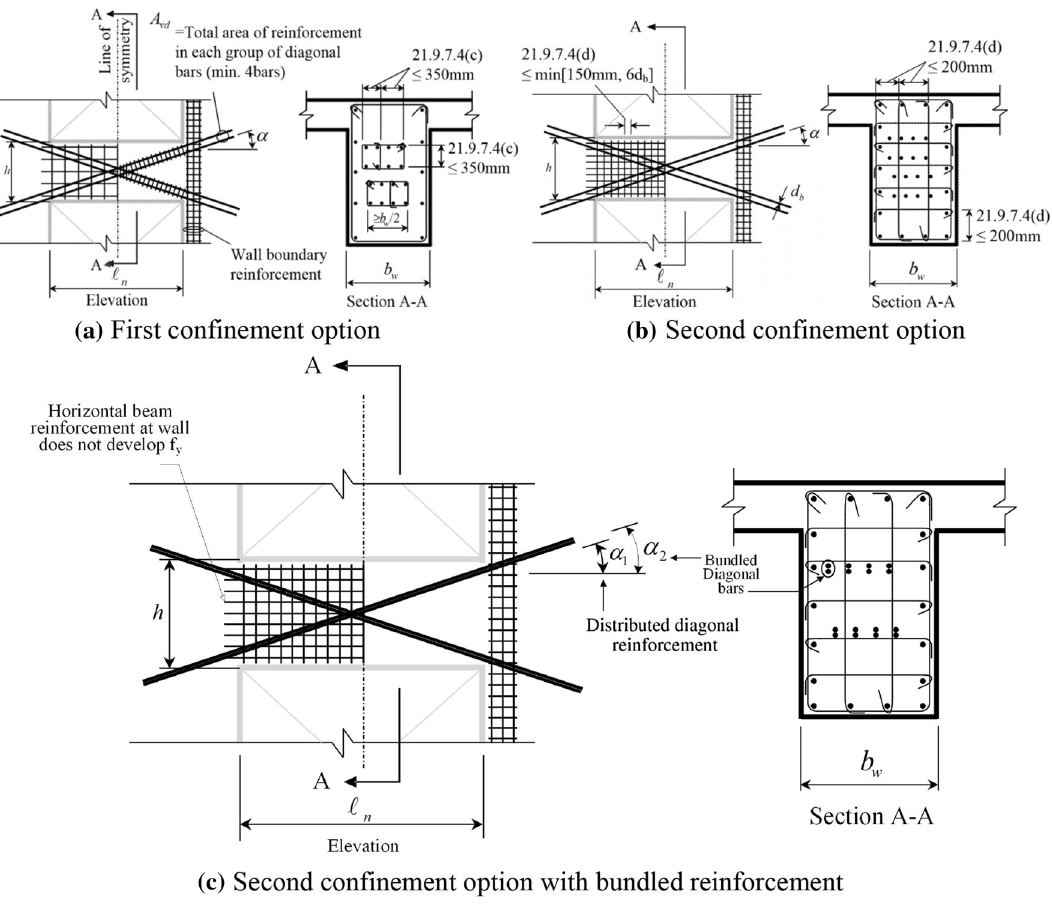
Fig. 1 Diagonally reinforced coupling beams [ a , b options specified in ACI 318-14 (ACI 2014), and c option with bundled diagonal